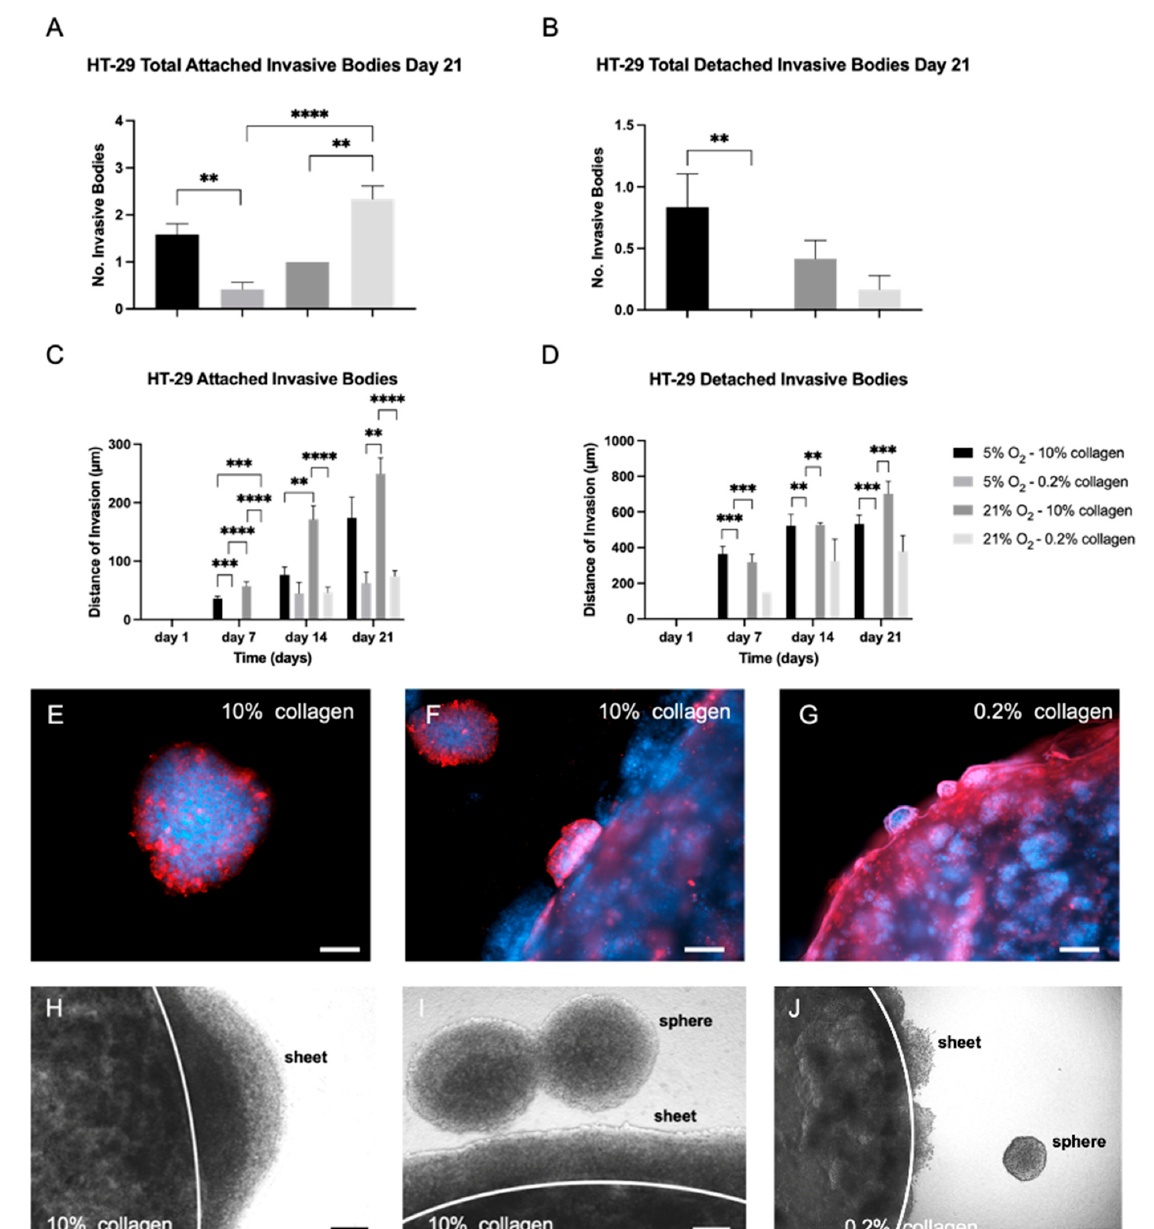
Figure 5. Number of invasive bodies and distance of invasion in HT-29 tumouroids with varying stiffness and oxygen concentrations. HT-29 tumouroids showed attached and detached invasive bodies. ( A ) Total number of attached invasive bodies within HT-29 tumouroids by day 21. ( B ) Total number of detached invasive bodies within HT-29 tumouroids by day 21. ( C ) Distance of invasion into the stromal compartment by attached invasive bodies over time within HT-29 tumouroids. ( D ) Distance of invasion into the stromal compartment by detached invasive bodies over time within HT-29 tumouroids. ( E , F ) Examples of invasive bodies into the stromal compartment within stiff 10% collagen tumouroids. ( G ) Example of minimal invasion into the stromal compartment of soft 0.2% collagen. Red = CK20; blue = DAPI; and scale bar = 50 µm for ( E ); 100 µm for ( F ); and 500 µm for ( G ). ( H , I ) Brightfield images of invasive bodies into the stromal compartment of stiff 10% collagen and ( J ) 0.2% collagen tumouroids. Scale bar = 100 µm for all. Significance shown for Kruskal–Wallis multiple comparisons test with Dunn’s post hoc correction. All p -value significance is indicated as: ** p < 0.005, *** p < 0.0005, **** p < 0.00005